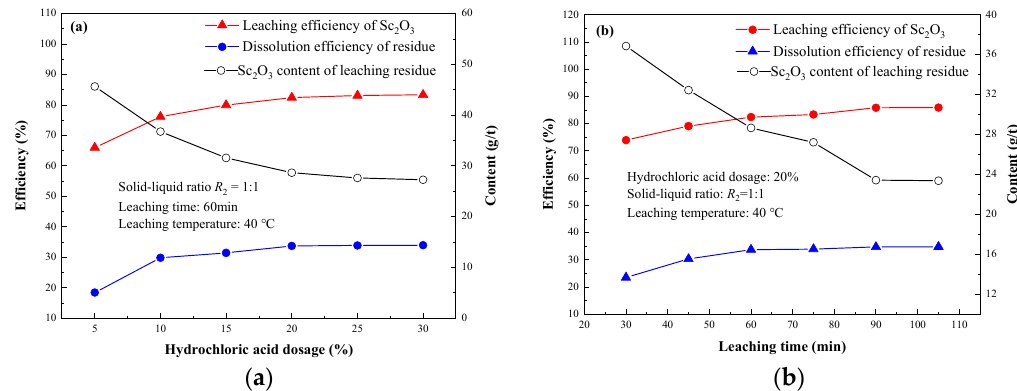
Figure 6. Effect results of hydrochloric acid dosage ( a ) and leaching time ( b ). Figure 6. E ff ect results of hydrochloric acid dosage ( a ) and leaching time ( b